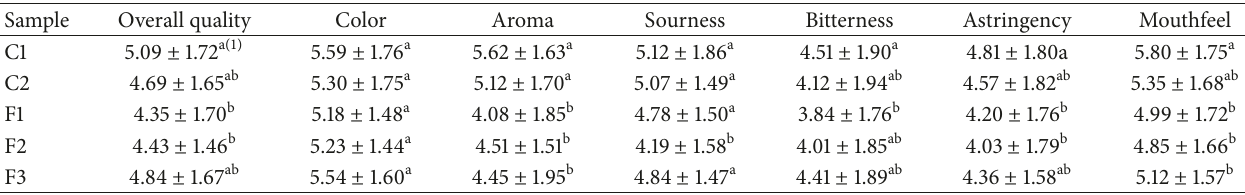
Table 3: Overall quality and acceptances of color, aroma, sourness, bitterness, astringency, and mouthfeel of yeast fermented coffee extract by 74 consumers.